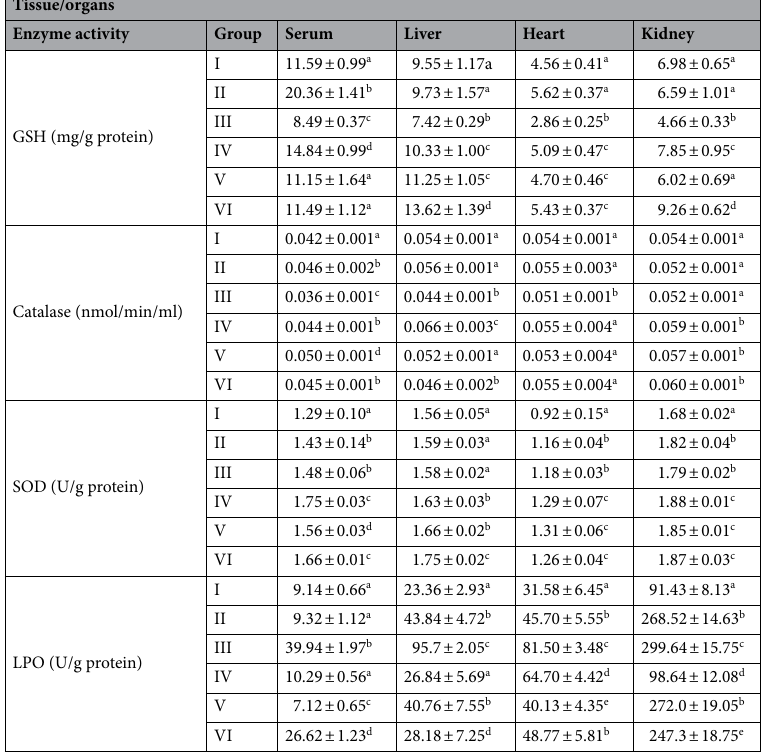
Table 9. Effect of P. americana extracts on GSH, CAT, SOD and LPO activities of the alloxan-diabetic rats. Values represent mean ± standard deviation (n = 5). Values with different superscripts (a,b,c,d,e) along the same column are significantly different from one another (P < 0.05). Group I—normal control rats, Group II— diabetic rats treated with glibenclamide, Group III—diabetic rats not treated, Group IV—diabetic rats